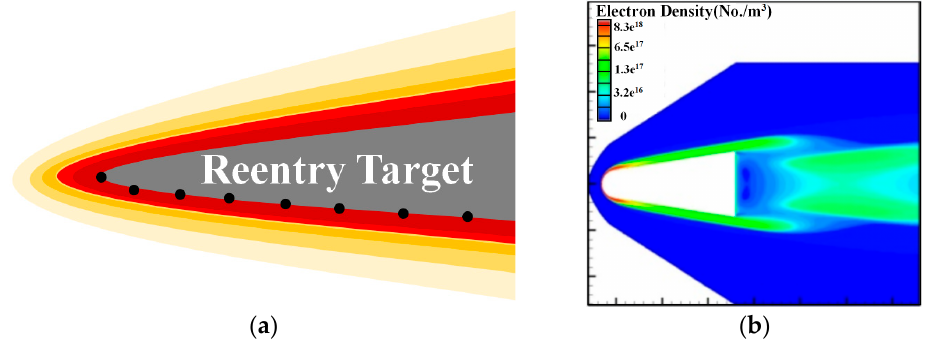
Figure 2. ( a ) PSh-covered target; ( b ) electron density calculation results.